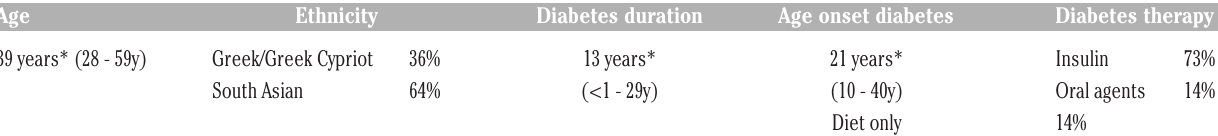
Table 1. Description of patients attending the joint